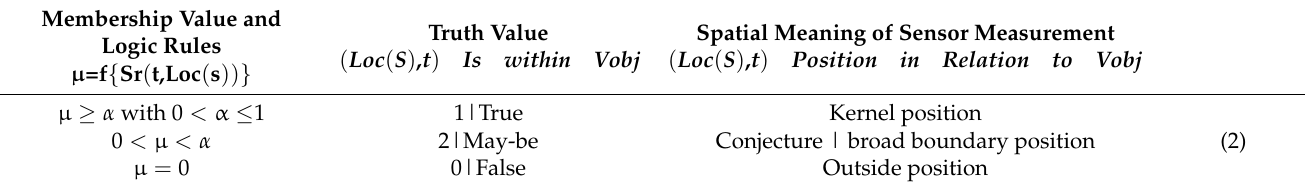
Table 1. Relation between the membership value of a RSD and the relative position of a sensor vis- à -vis the vague object. Membership Value and Logic